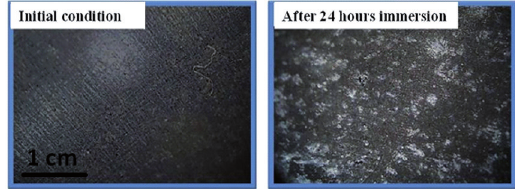
Figure 10: Macrograph of the top surface of the welded repair before and after the immersion test.